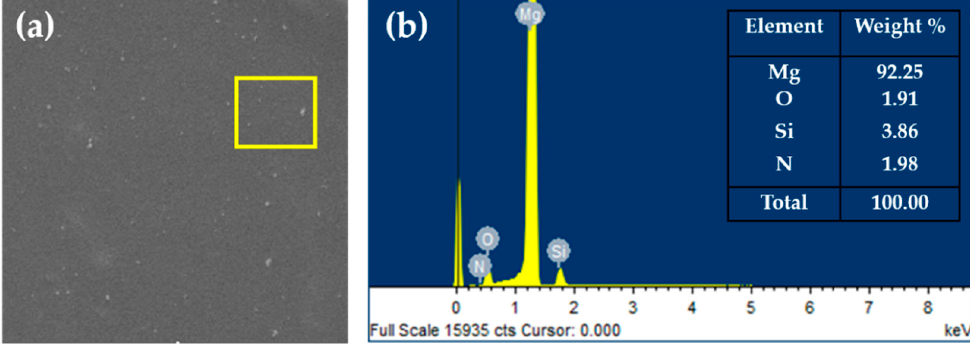
Figure 2. Representative SEM micrograph and EDX spectrum of the Mg ‐ 1.5Si 3 N 4 nanocomposite. ( a ) SEM micrograph of mapped area, ( b ) EDX spectrum with elemental composition.